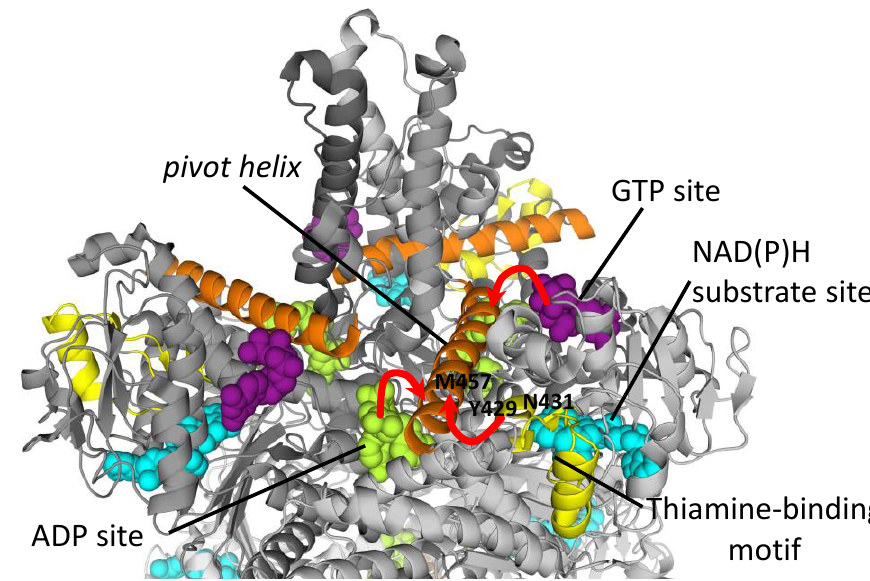
Figure 5. GDH regulatory sites. Different subunits of bovine glutamate dehydrogenase (PDB: 3JD4) are shown in different shades of gray. Space filling models depict GTP in the inhibitory center (purple), NADH in the substrate-binding center (cyan) and NADH in the ADP-activator center (green). A pivot helix is shown in orange, and the thiamine-binding motif described earlier [116],—in yellow. Positions of the residues of the thiamine-binding motif interacting with M457 of the pivot helix (Y429), and with the substrate binding site for NADH (N431) are indicated. The red arrows indicate interactions between the GDH allosteric sites, mediated by the pivot helix.